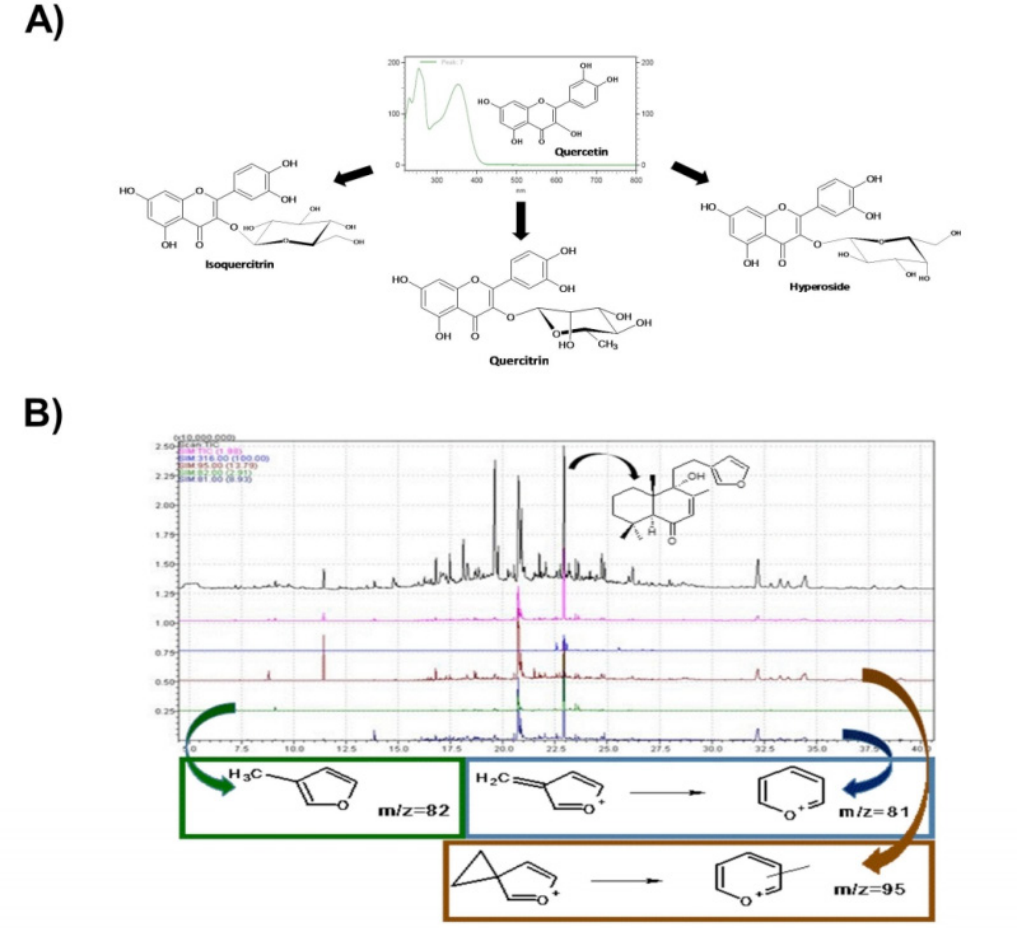
FIGURE 2 - Phytochemical constituents of the SCIE. UV from quercetin and their derivatives glycosides, all these substances were characterized in the HPLC-UV-PAD of SCIE (A). Inflorescences ether-ethanol extract total ion chromatogram (TIC) of solidagenone – the main labdane diterpene from S. chilensis - with selective-ion monitoring